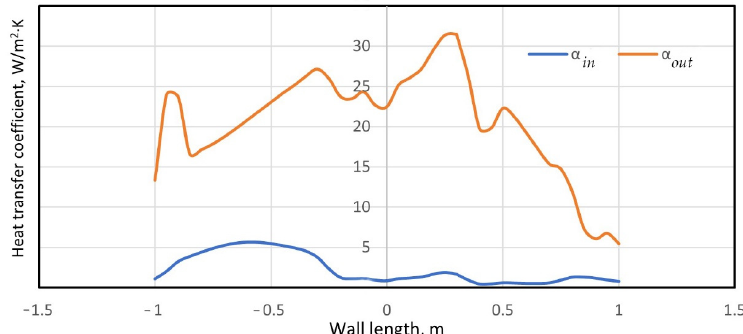
Figure 9. Heat flux q on the left wall.